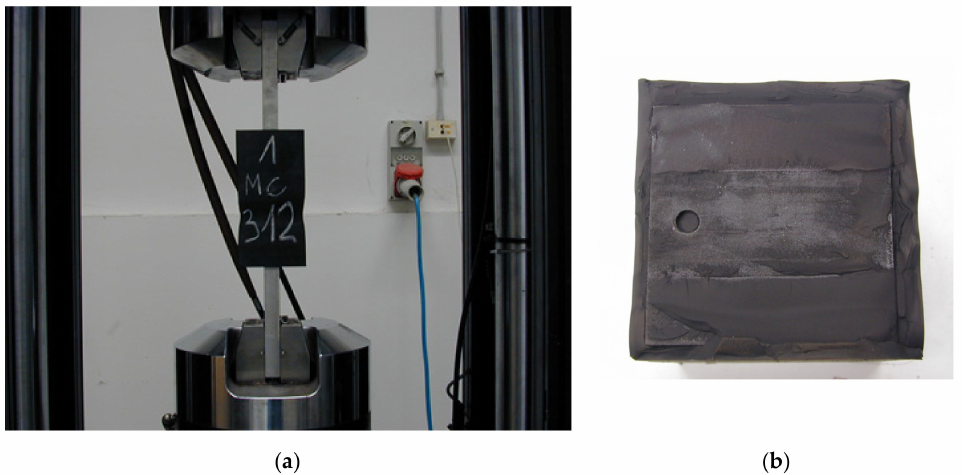
Figure 4. Sample 11 ( a ) just before failure; ( b ) after cohesive failure.